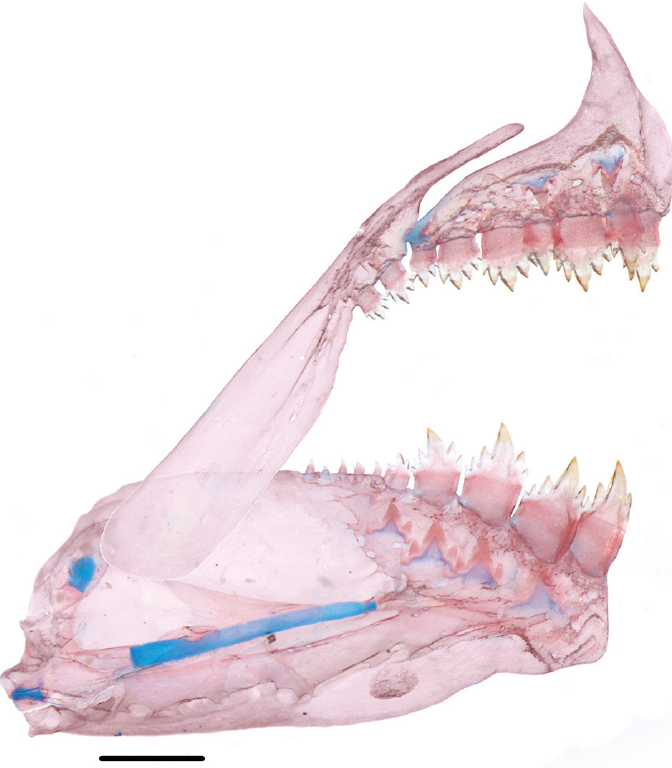
FIGURE 2 | Lateral view of right side, premaxillary, maxillary, and dentary of Astyanax nobre , MZUSP 118302, paratype. Scale bar = 0.5